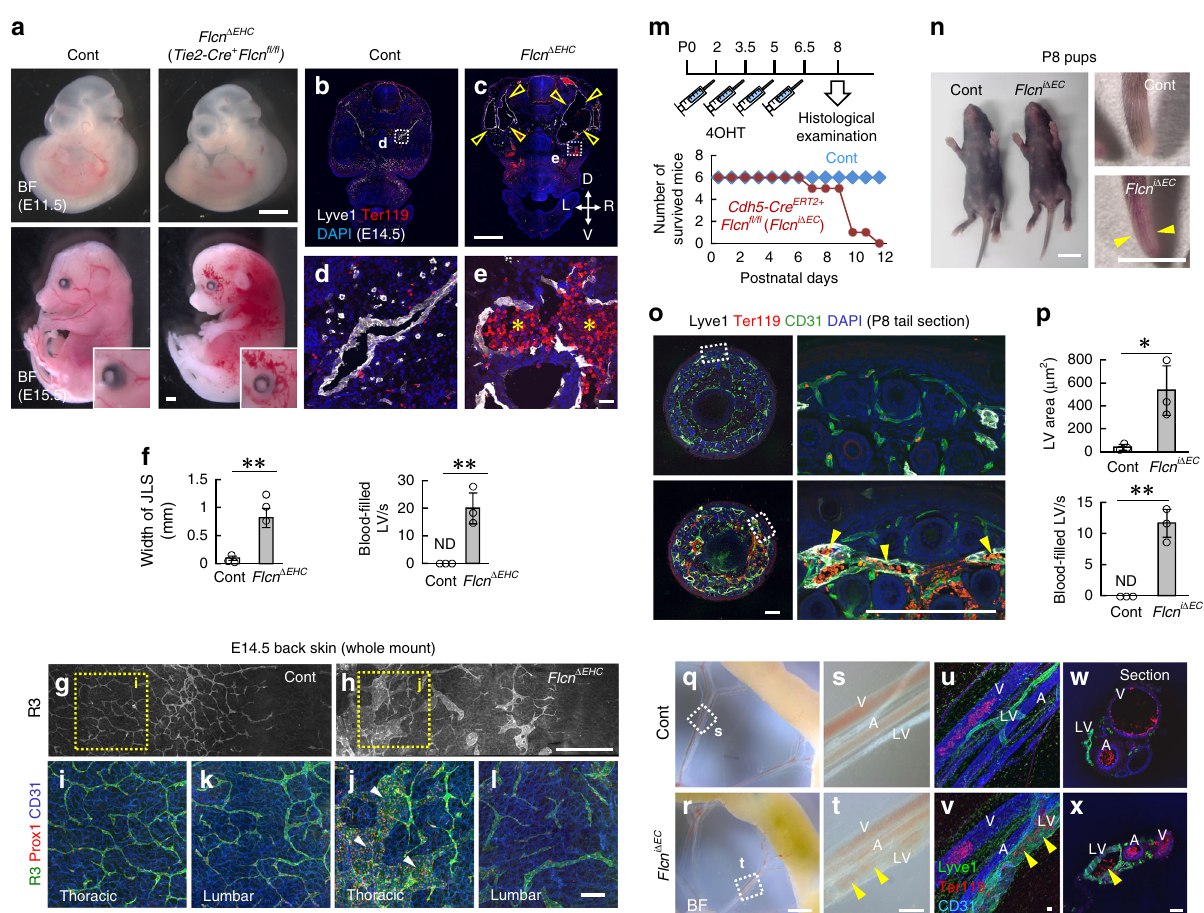
Fig. 1 Flcn de fi ciency causes blood- fi lled and dilated lymphatics. a Images of Flcn Δ EHC mice at embryonic day (E)11.5 or E15.5. b – l Transverse sections ( b – e ) or whole-mount skin samples ( g – l ) of E14.5 embryos and quanti fi cation ( n = 3). Flcn Δ EHC embryos show dilated (open and closed arrowheads) and blood- fi lled (asterisks) lymphatic vessels. m Protocol for 4-hydroxytamoxifen (4OHT) injection in neonates and survival curve of control and Flcn i Δ EC mice (each n = 6). P postnatal. n – p )Control and Flcn i Δ EC pups and tail sections at P8, and quanti fi cation after staining with the indicated antibodies ( n = 3). Flcn i Δ EC mice show reddish colored skin (arrowheads in n ) as well as dilated and blood- fi lled LVs (arrowheads in o ). q – x Bright fi eld views and whole-mount or section samples of mesentery at P8. Erythrocytes (closed arrowheads) are detected not only in arteries (A) and veins (V) but also in LVs of Flcn i Δ EC mice. Scale bars: 5 mm ( o ); 1 mm ( a – c, g, h, q, r ); 200 µ m ( i – l, o, s, t ); 50 µ m ( d, e, u – x ). ** P < 0.01; * P < 0.05; ND not detected. Data presented are the mean ± SD. The comparisons between the averages of the two groups were evaluated using the two-sided Student ’ s t -test. Source data are provided as a Source Data fi